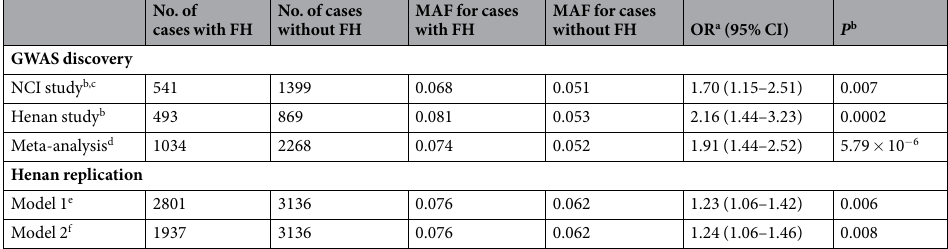
Table 1. The association between rs79747906 (T-C) and family history in ESCC cases. FH: family history; MAF: minor allele frequency; odds ratio: OR. a The P -values and ORs per one effect allele (the minor allele C) were calculated from unconditional logistic regression models using genotype-trend tests adjusted for age, sex and sub-study (for the analysis of NCI study, which includes NCI Shanxi and NIT). b ESCC cases with FH of UGI cancer (FH + ) were defined as those having one or more relative(s) diagnosed with UGI cancer within three generations for NCI/Shanxi study and Henan study. c For the smaller NCI study (NIT), FH was limited to those having one or more relative(s) diagnosed with UGI cancer within first-degree relatives. d Calculated using the fixed-effects model as no heterogeneity was found between the two studies ( P = 0.41). e ESCC cases with family history were defined as those that have one or more relative(s) within three generations diagnosed with UGI cancer. f ESCC cases with family history were defined as those that have one or more relative(s) within first- degree diagnosed with UGI